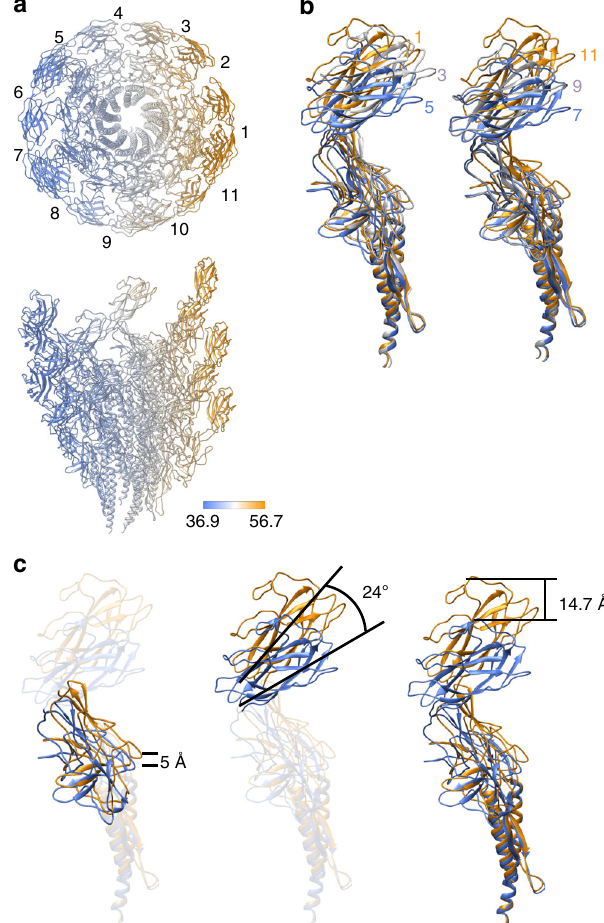
Fig. 2 Conformational differences of FlgE subunits depending on the proto fi lament position. a End-on and side views of the supercoiled hook color-coded for the distance between corresponding residues of neighboring subunits along each proto fi lament. Each of the 11 proto fi laments are numbered from 1 to 11, with proto fi lament 1 for the longest (extended) and 6 and 7 for the shortest (compressed). In end-on view, just one subunit is shown for each proto fi lament for clarity. b Superimposition of FlgE subunits from proto fi laments 1, 3 and 5 (left) and from proto fi laments 7, 9 and 11 (right). c Changes in position and orientation of domains D1 and D2 relative to D0 by its superposition. Color codes are in a gradient from blue for shortest (compressed) to orange for the longest